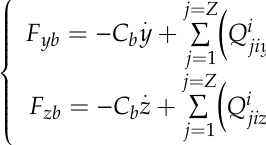
20 Table 2. Nodes and elements of GCRS. Parameters of Elements